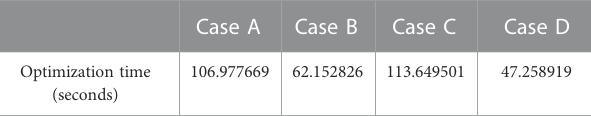
TABLE 1 Computational time analysis by different